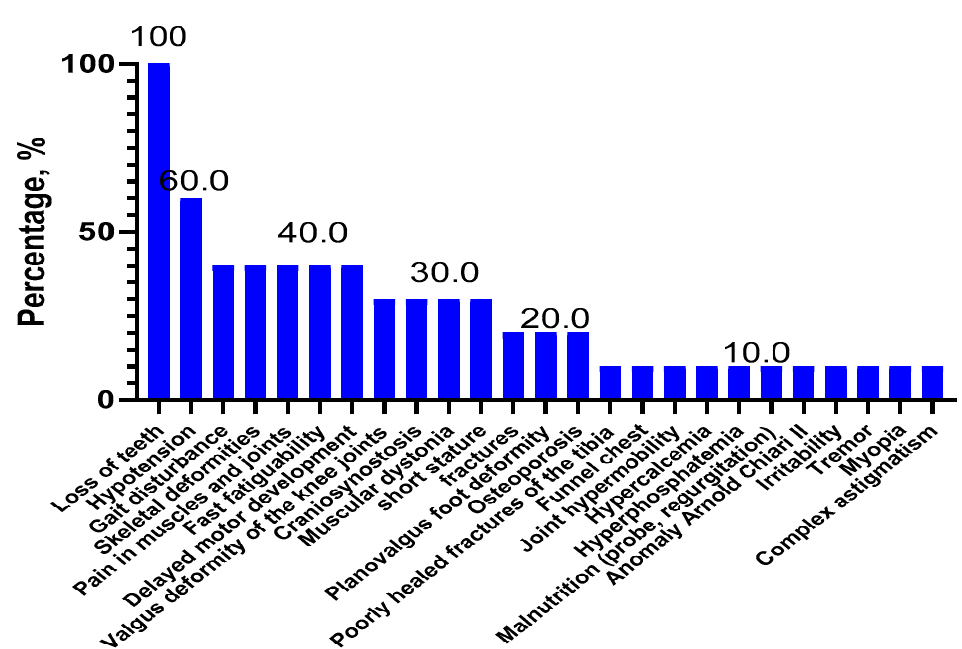
Figure 4. Clinical symptoms of HPP in patients with childhood HPP ( n = 10).